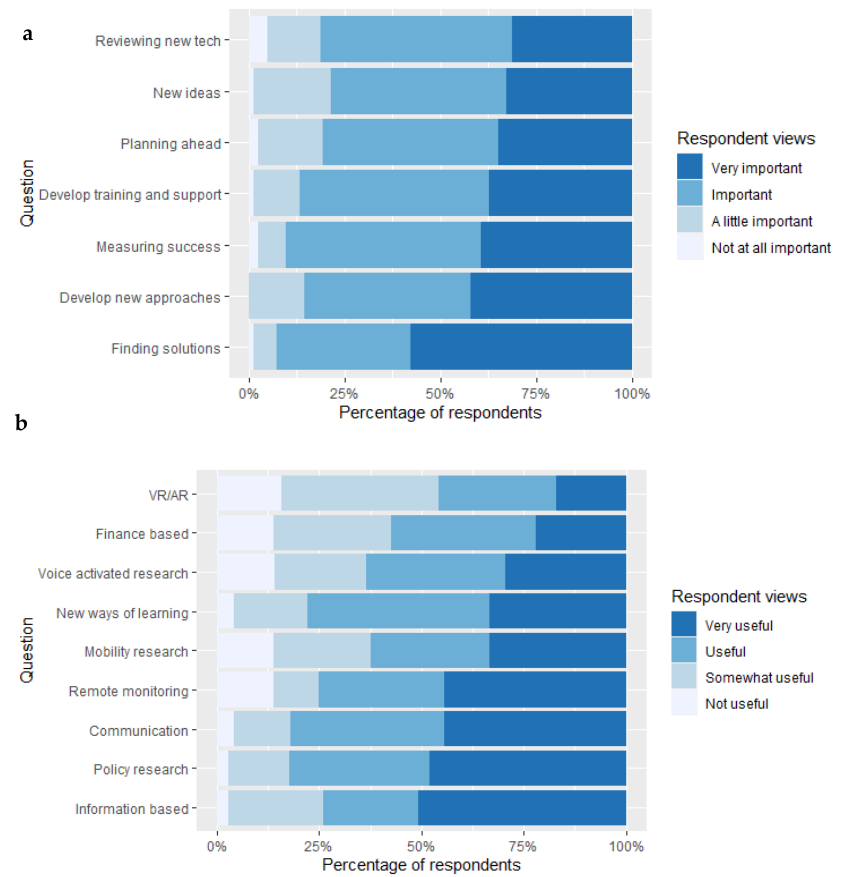
Figure 2. ( a ) Caregivers’ responses to a range of statements according to whether they are “Very